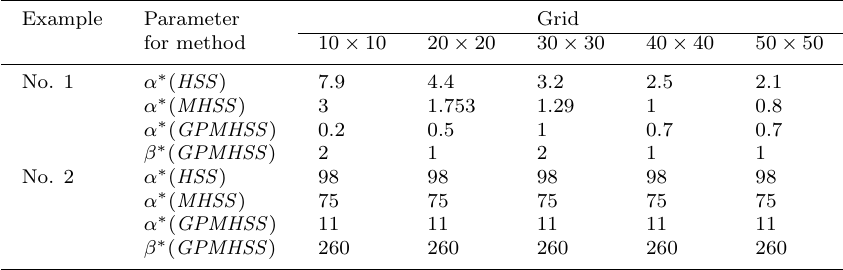
Table 1. The experimentally optimal parameters for HSS, MHSS, and GPMHSS iteration methods.